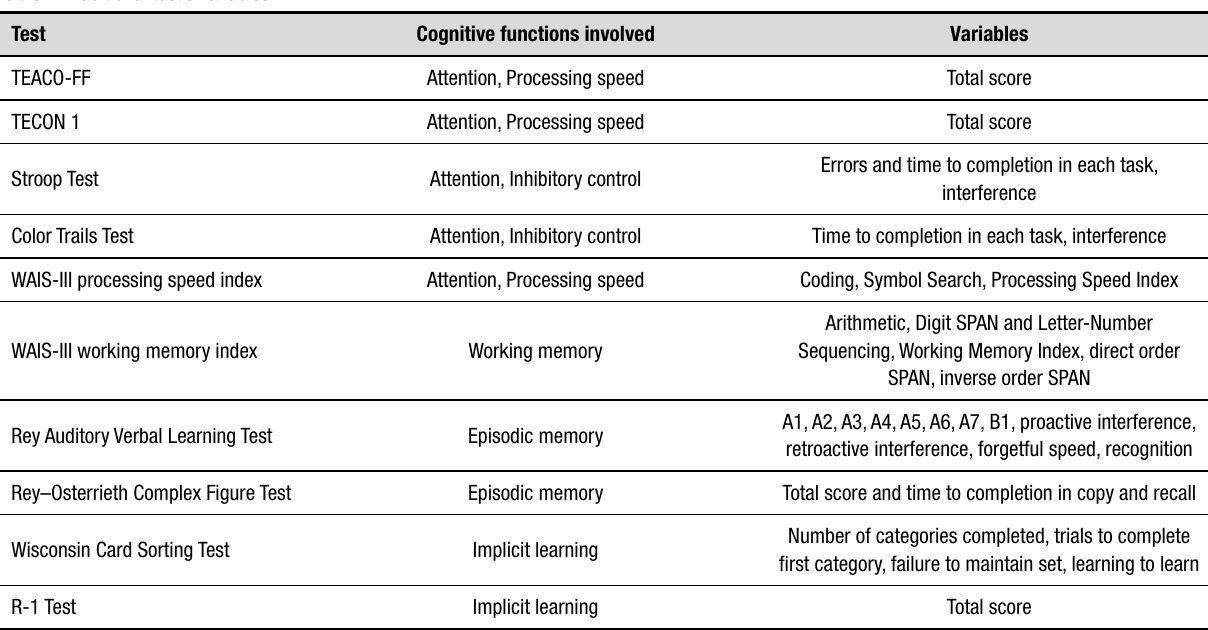
Table 2. Traditional test’s